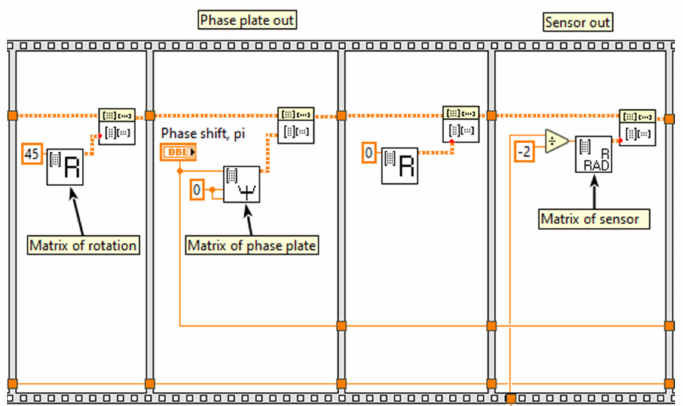
Figure 14. FOCS modeling in LabVIEW (the block